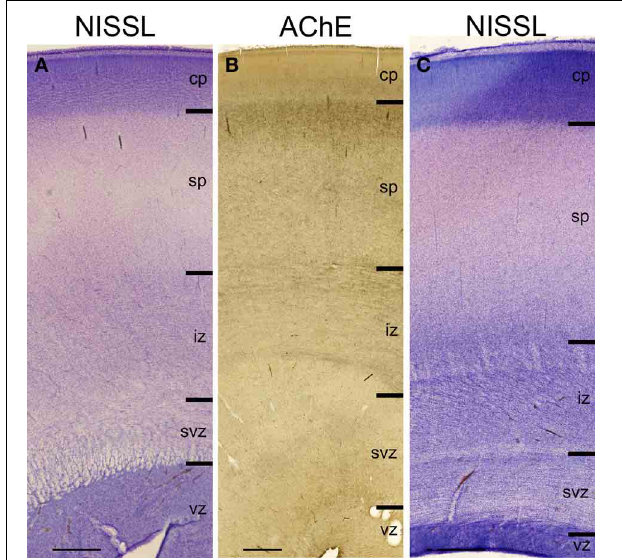
FIGURE 1 | Laminar development of human telencephalon from 10 postconceptional weeks (PCW) to newborn. The layers are transient and their appearance changes with changes in neurogenetic events. The subplate starts to develop around 13PCW, reaches the peak of its development between 22 and 24PCW, and starts to resolve around 34PCW. In the newborn brain, the subplate remains during the first year, when the subplate disappears as a zone but its neurons become incorporated into the subcortical white matter as so-called interstitial neurons. cp, cortical plate; sp, subplate zone; iz, intermediate zone; svz, subventricular zone; vz, ventricular zone. Bar = 100 µ m (A) , 250 µ m (B) , 1mm (C–E) .